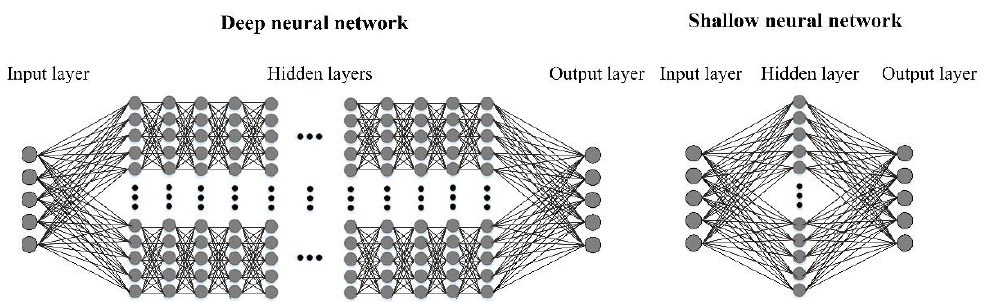
Figure 3. Topical shallow and deep neural network architectures [49].